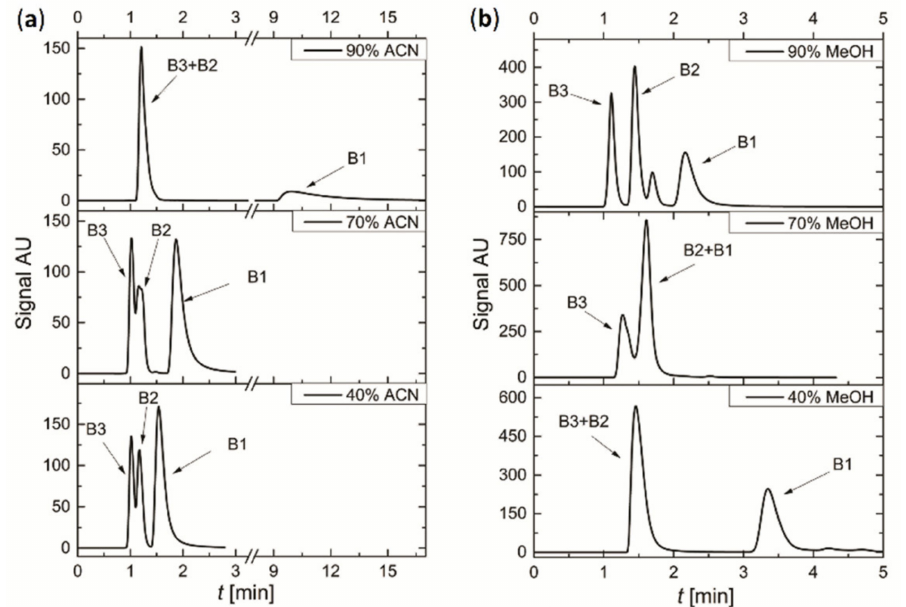
Figure 9. Preliminary results of separation of vitamin mixture obtained using column N (Nucle- odur C18 Gravity–SB) with: ( a ) acetonitrile–ammonia acetate buffer (10 mmol/dm 3 , pH 5)